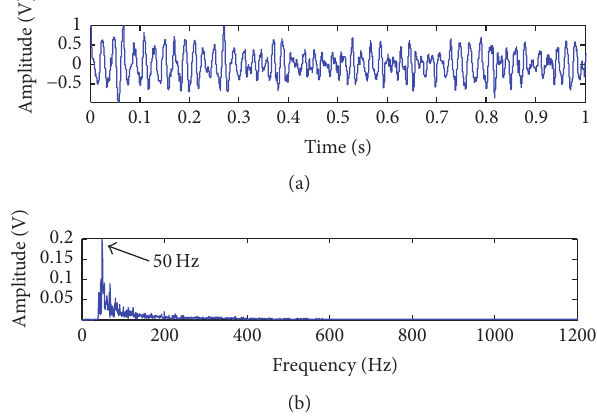
Figure 7: Optimal output signal of IMF1: (a) time-domain wave- form; (b) frequency spectrum.